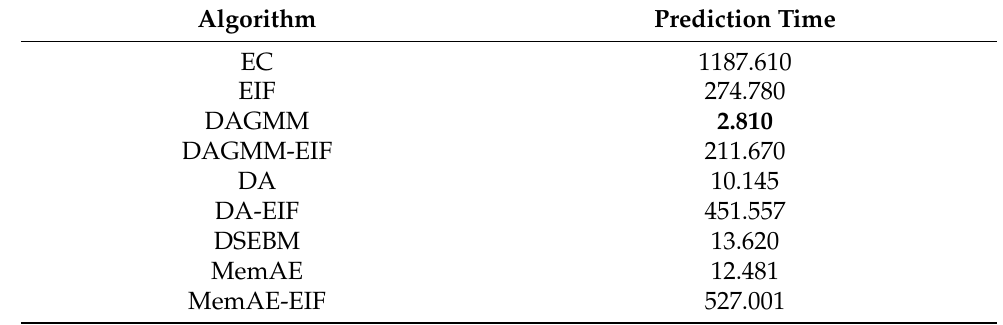
Table 2. Prediction times for analyzing 1000 records of the KDDCUP99 dataset. Times shown in the table are measured in